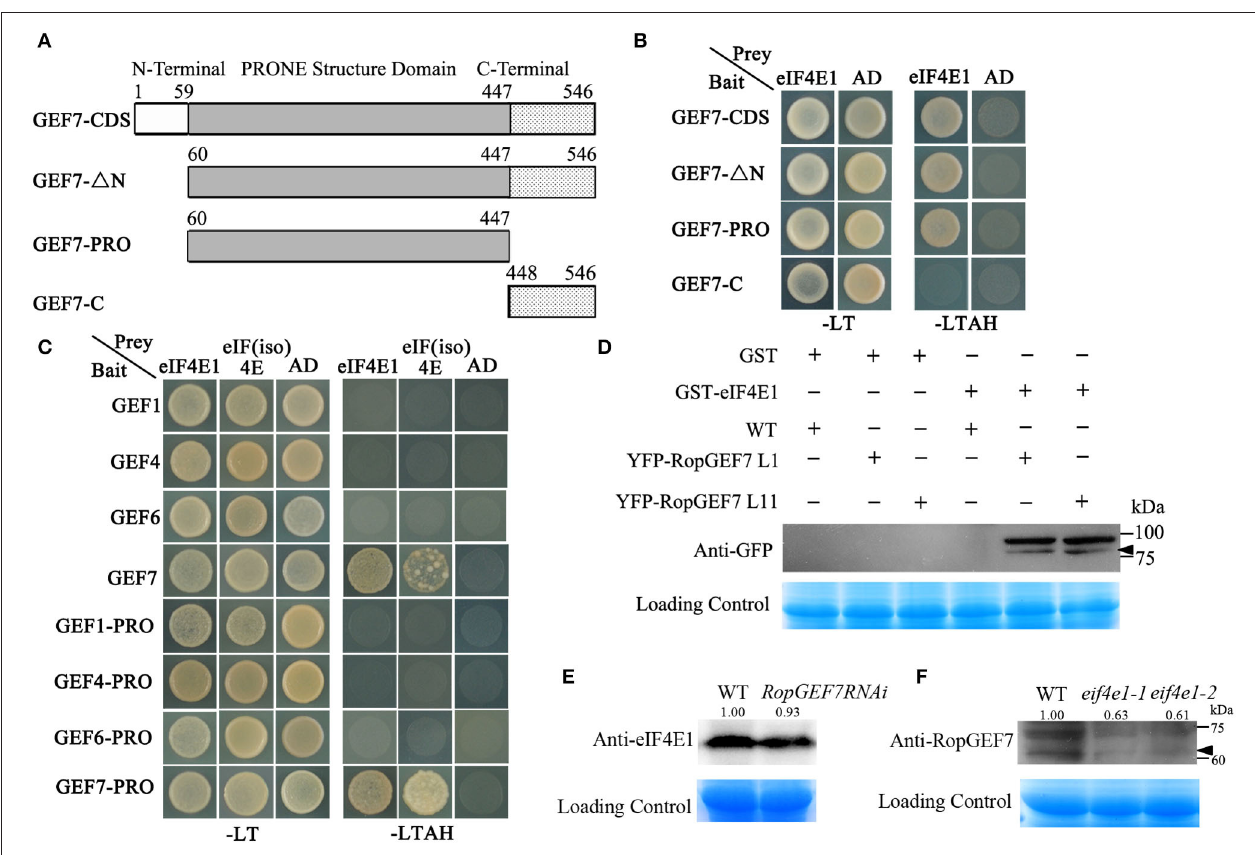
FIGURE 6 | eIF4E1 interacts with RopGEF7. (A) Schematic representation of the different truncated versions of RopGEF7. (B) Yeast two-hybrid assay showed that eIF4E1 interacted with RopGEF7-CDS, - 1 N, and -PRONE, respectively. SD/-LT indicates SD/-Leu-Trp; SD/-LTAH indicates SD/-Leu-Trp-Ade-His. (C) Yeast two-hybrid assay showed that eIF4E1 and eIF(iso)4E interacted with RopGEF7-CDS and -PRONE, respectively. (D) Pull-down assays indicate the interactions between eIF4E1 and RopGEF7. 35S pro :YFP-RopGEF7 indicates 35S pro :YFP-RopGEF7 transgenic plants. L1 and L11 indicate two individual 35S pro :YFP-RopGEF7 transgenic lines. GFP antibody was used for detection. (E) Abundance of eIF4E1 protein in RopGEF7 RNAi transgenic line was detected by Western blotting. Anti-eIF4E1 was designated as eIF4E1 antibody. (F) Abundance of RopGEF7 protein in eif4e1-1 and eif4e1-2 was detected by Western blotting. Anti-RopGEF7 was designated as RopGEF7 antibody. The protein amount was quantified by its loading control for each sample, and the protein value of the wild type was set as one. The values are shown up the bands in (E,F) . The black arrowheads indicate the aim protein bands in (D,F)